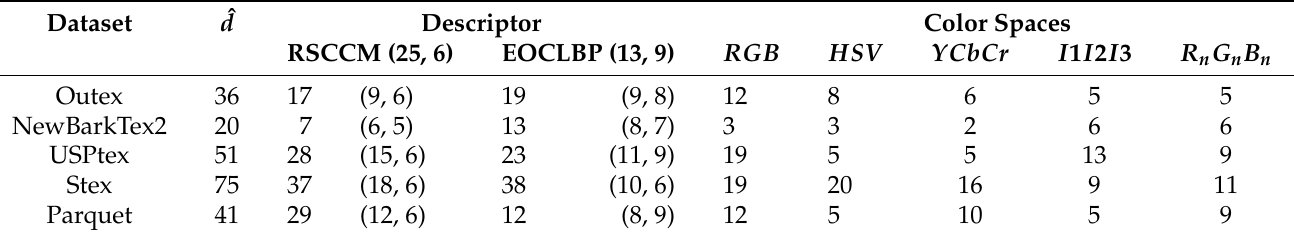
Table 6. Distribution of the selected features.